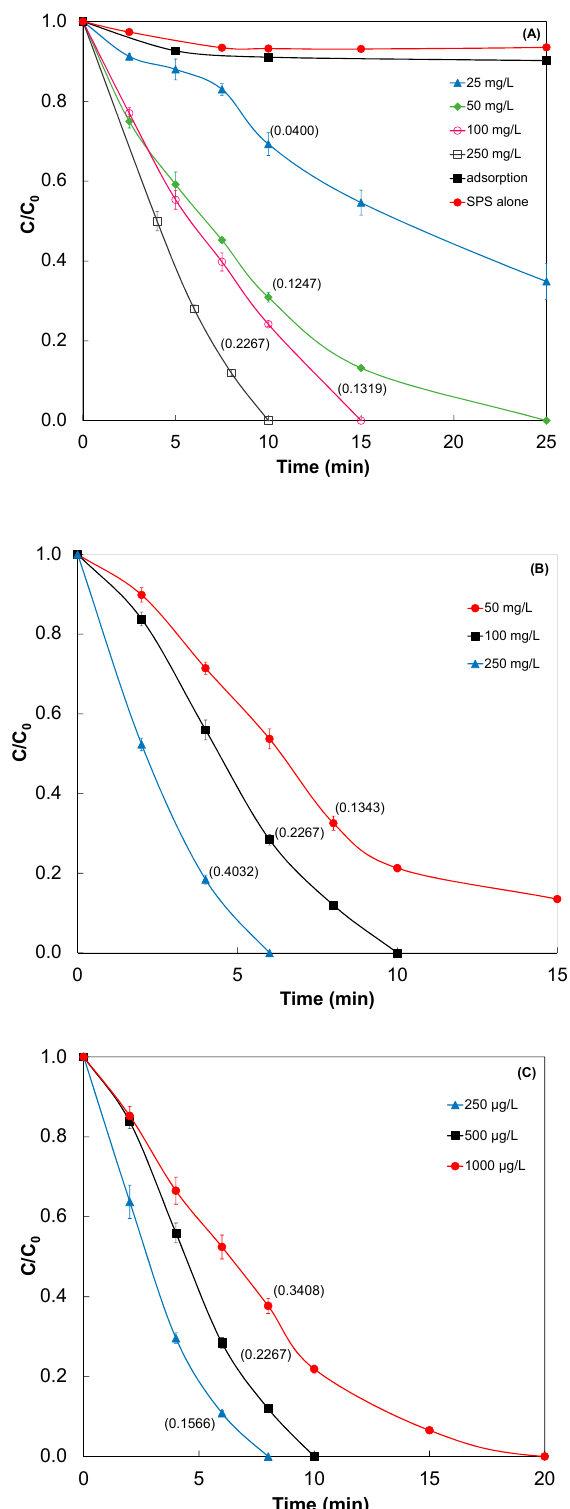
Figure 3. ( A ) E ff ect of LNO, ( B ) sodium persulfate (SPS) and ( C ) sulfamethoxazole (SMX) concentration Figure 3. ( A ) Effect of LNO, ( B ) sodium persulfate (SPS) and ( C ) sulfamethoxazole (SMX) on SMX degradation in LaNiO 3 / SPS system. Experimental conditions: C SMX = 500 µ g / L for a and b; concentration on SMX degradation in LaNiO 3 /SPS system. Experimental conditions: C SMX = 500 μ g/L C LNO = 250 mg / L for b and c; C SPS = 100 mg / L for a and c; pH = 6; room temperature. Numbers next to for a and b; C LNO = 250 mg/L for b and c; C SPS = 100 mg/L for a and c; pH = 6; room temperature. lines show apparent rate constants (k in min − 1 Numbers next to lines show apparent rate constants (k in min ‐ 1 ).